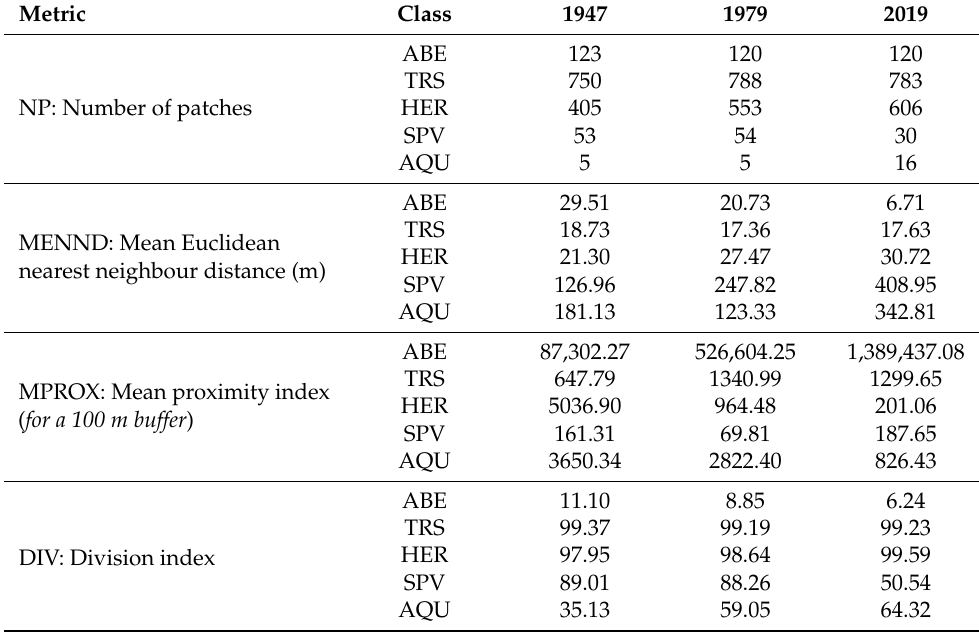
Table A4. Aggregation metrics at the class level, for 1947, 1979, and